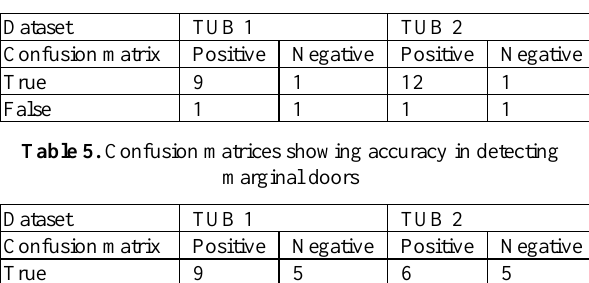
Table 2. Parameters controlling door candidate detection